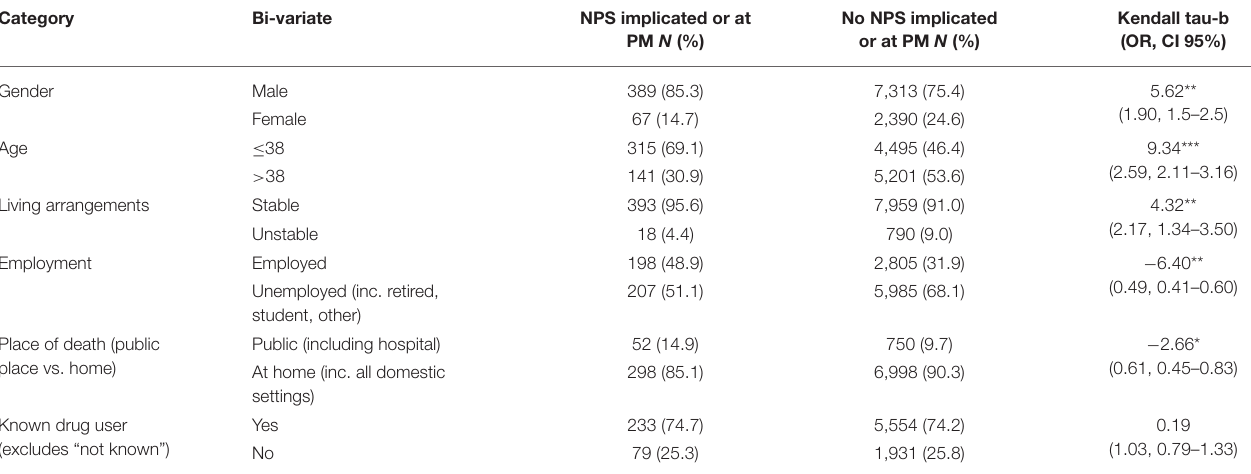
TABLE 2 | Whole cohort demographic and outcomes by gender † .